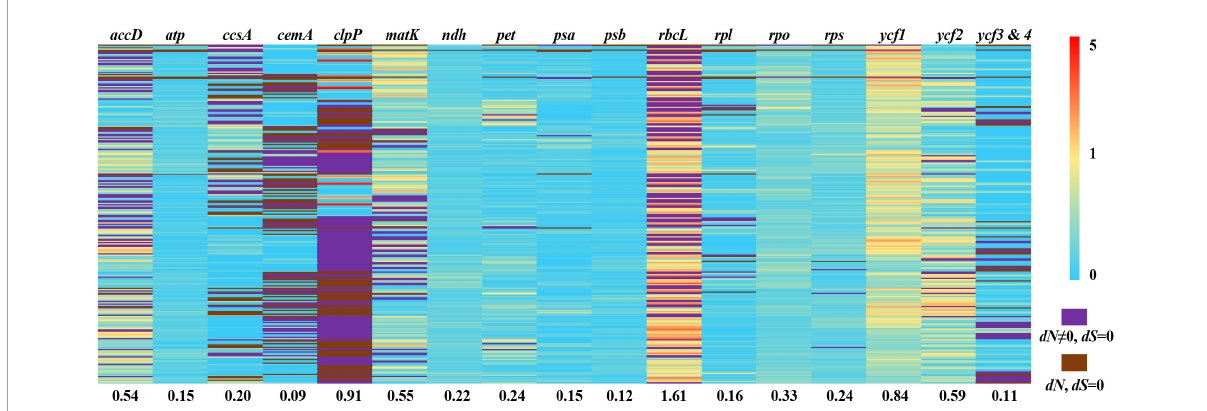
FIGURE6 Pairwise non-synonymous rates ( dN )/synonymous rates ( dS ) ratios in Ficus . This heatmap shows pairwise dN / dS ratios of 78 protein-coding genes from 24 Ficus species. The number under each gene dataset represented the mean dN / dS ratio. The order of species pairs showed in Supplementary Table 8